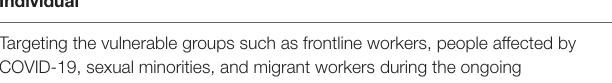
TABLE 2 | Recommendations to reduce the stigma associated with suicide in the context of COVID-19.